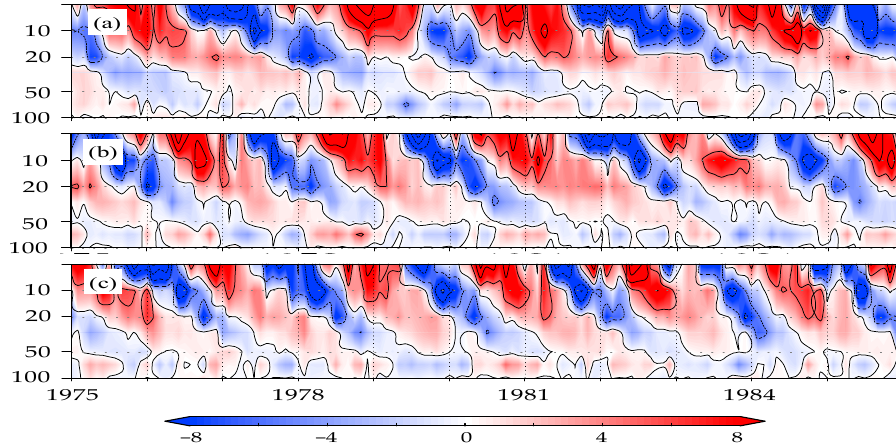
Figure 7. Time–height cross-sections of zonal–mean terrestrial heating anomalies averaged between 10 ◦ S and 10 ◦ N in the tropical stratosphere for the ( a ) P, ( b ) ST, and ( c ) N runs from 1975 to 1985. Units of the color bar scale are in K mon − 1 , and the contours interval is 5 K mon − 1 .